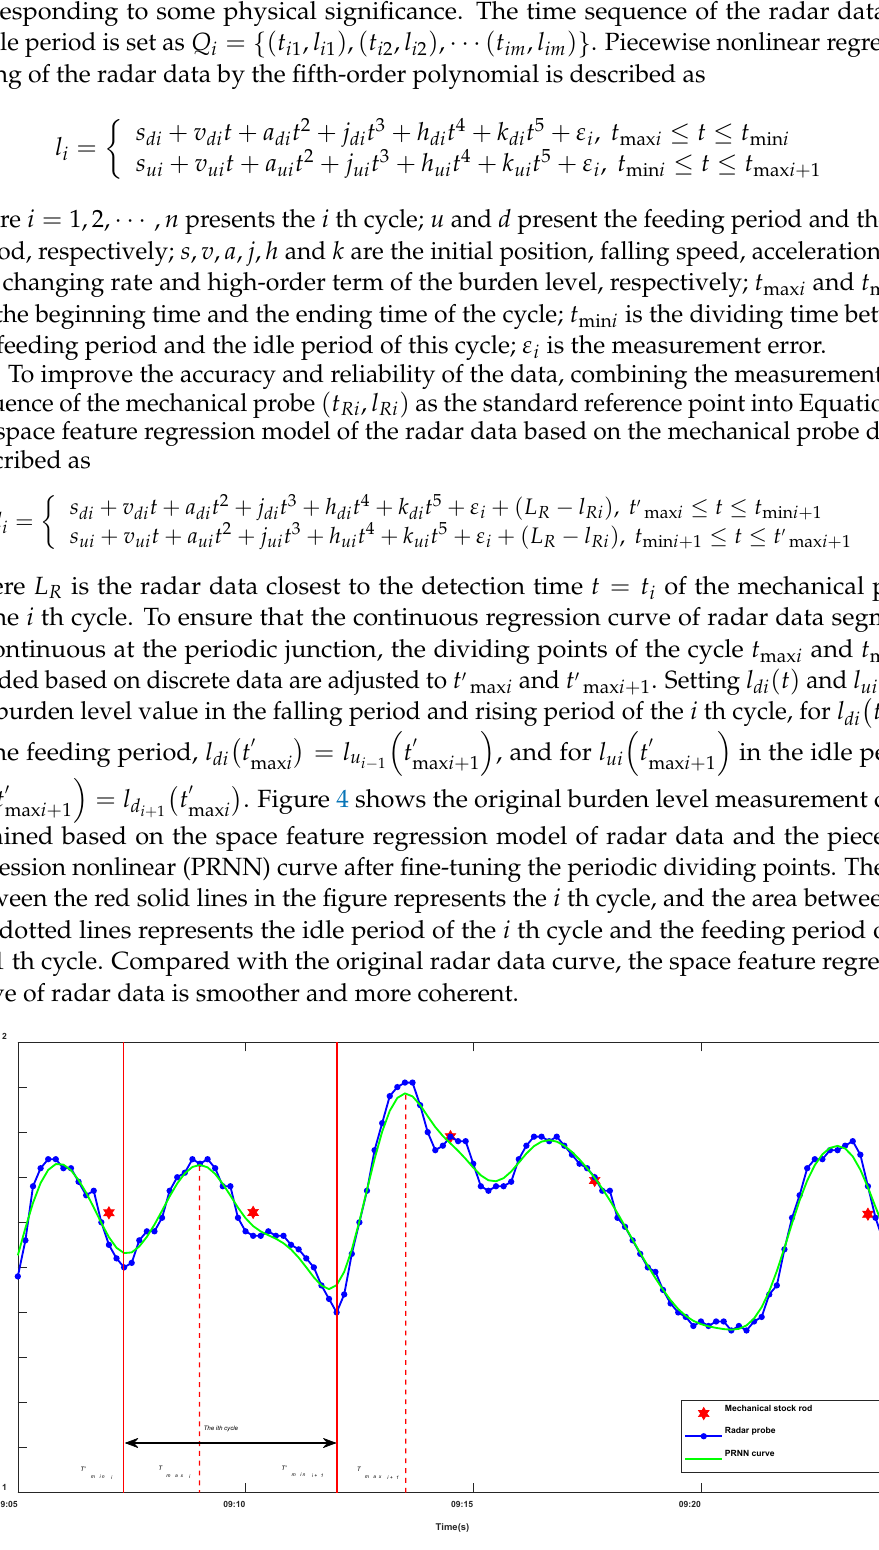
Figure 4. Space feature regression model curve of radar data.